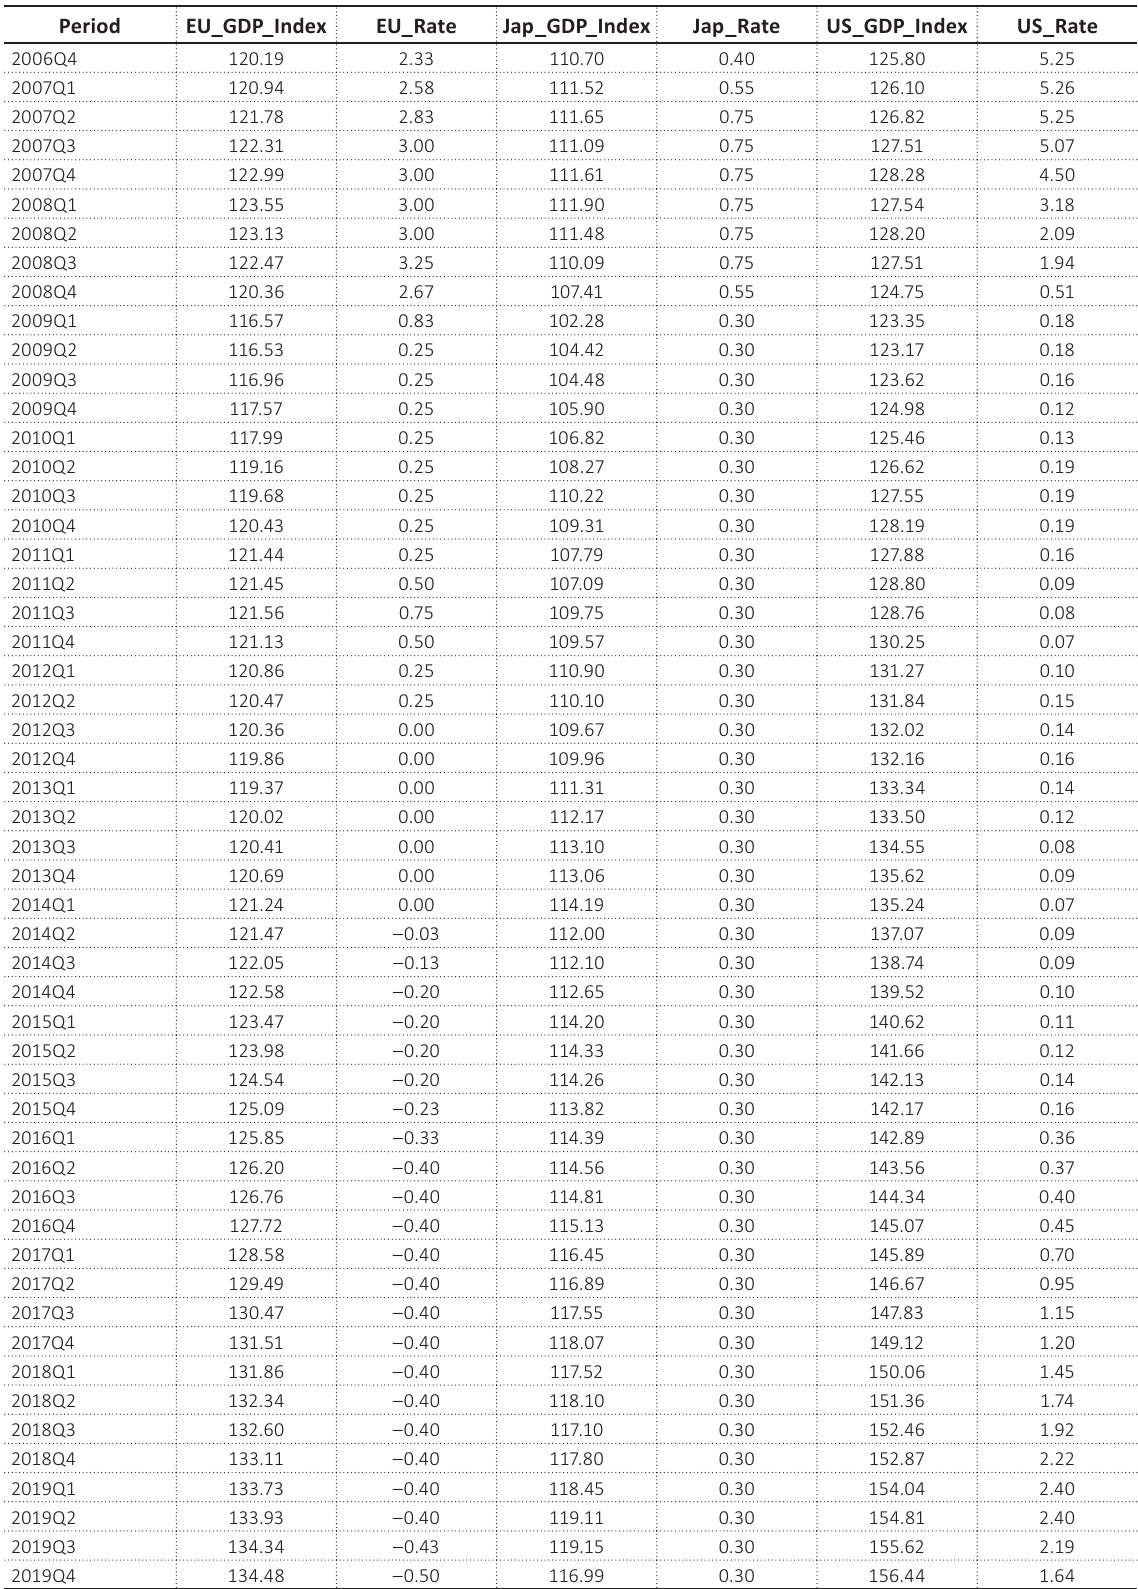
Table A2 (cont.). Data set for the